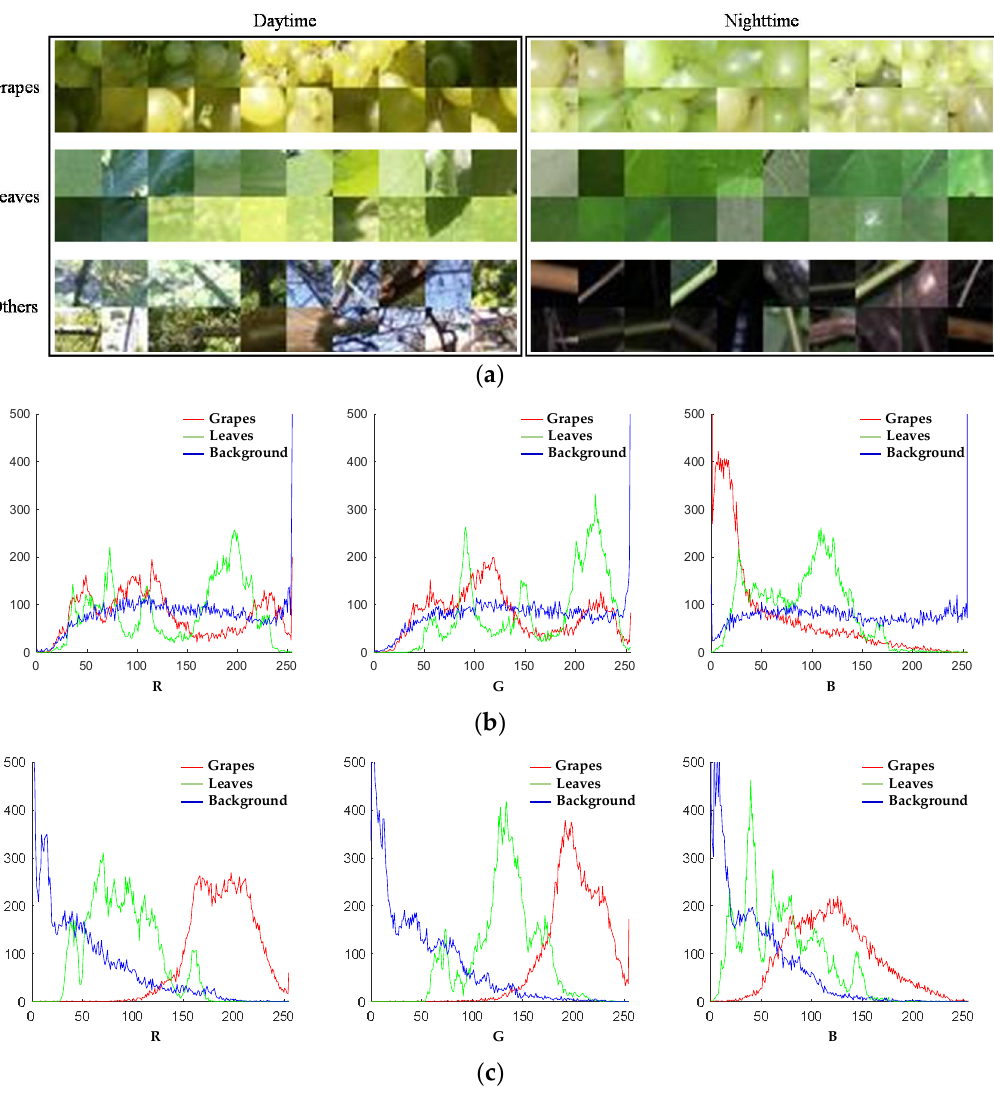
Figure 3. Color feature analysis of the acquired images. ( a ) Samples of image blocks; ( b ) color distribution of daytime red, green and blue (RGB) image; ( c ) color distribution of night-time RGB image.